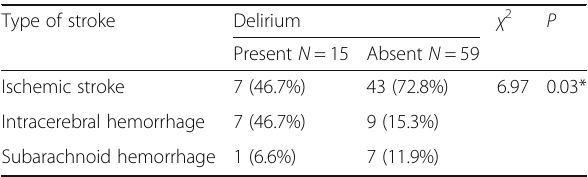
Table 3 Delirium frequency according to type of stroke Type of stroke